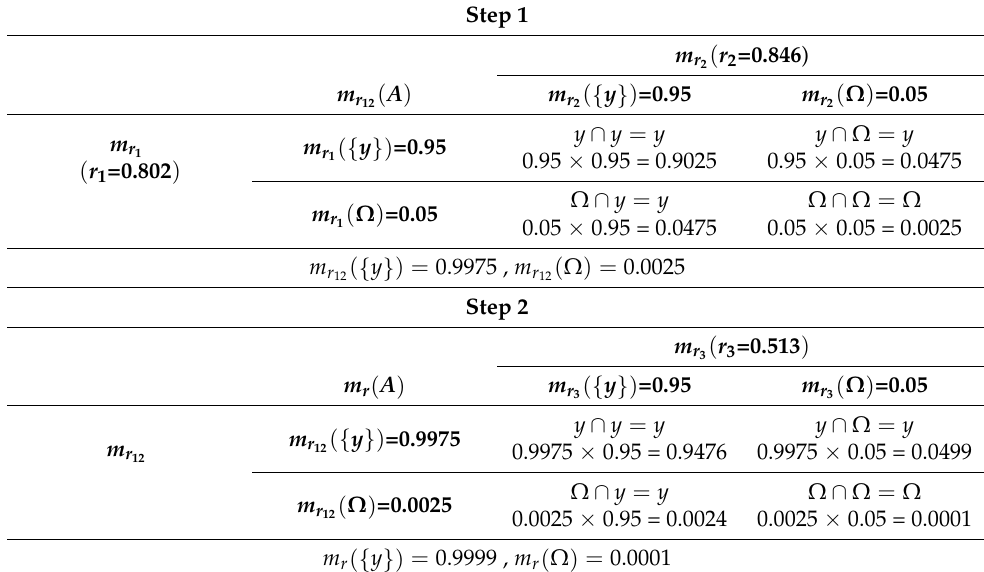
Table 5. Numerical application example of a combination of the mass functions m r machine